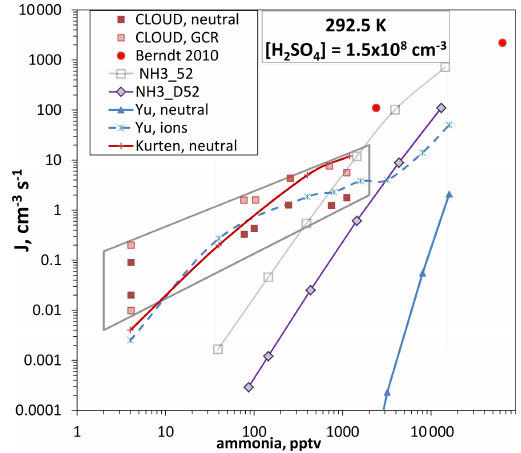
Figure 7. Nucleation rate J versus ammonia level for [H 2 SO 4 ] = 1 . 5 × 10 8 cm − 3 and 292.5K. Berndt et al. (2010) 50%RH and CLOUD at 38%RH (Dunne et al., 2016, also included are low ionization rate measurements, “GCR”; the data at 4pptv NH 3 were for H 2 SO 4 up to 3 × 10 8 cm − 3 ). Box model calculations (described in Hanson et al., 2019) using two different thermodynamic schemes for 52%RH are also shown (NH3_D52 this work; NH3_52 presented previously; Hanson et al., 2019). Red solid line from Kürten (2019). Ammonia nucleation from Yu et al. (2020) where neutral is the ternary system (THN) equation and “ions” is the ternary system (TIMN) equation with an ion pair production rate of 2cm − 3 s − 1